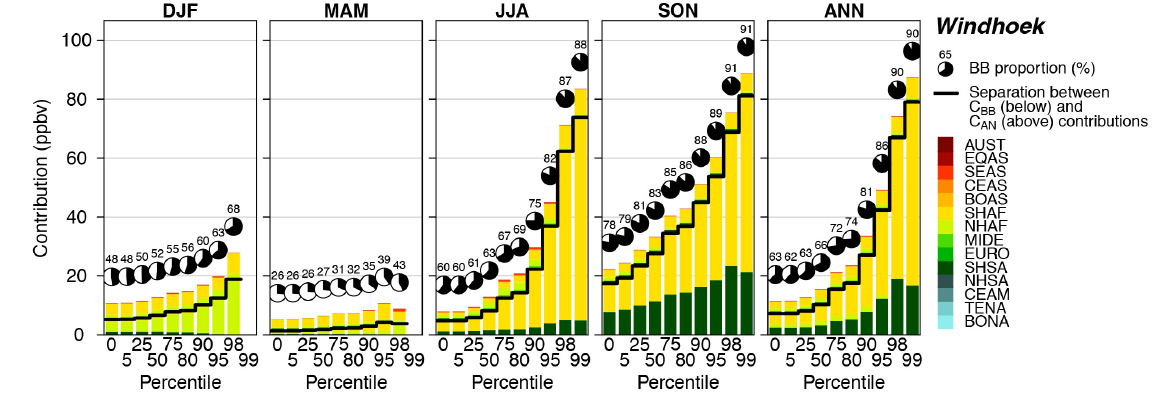
Figure 22. Same as Fig. 16 for Windhoek